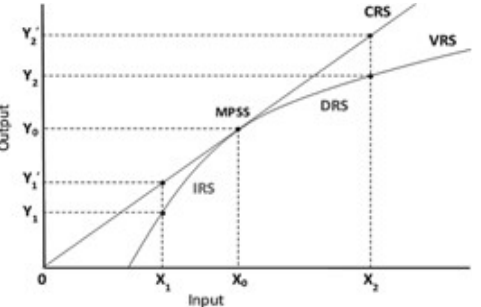
Figure 2: CRS, VRS, IRS, DRS Production Function Source : Smart,